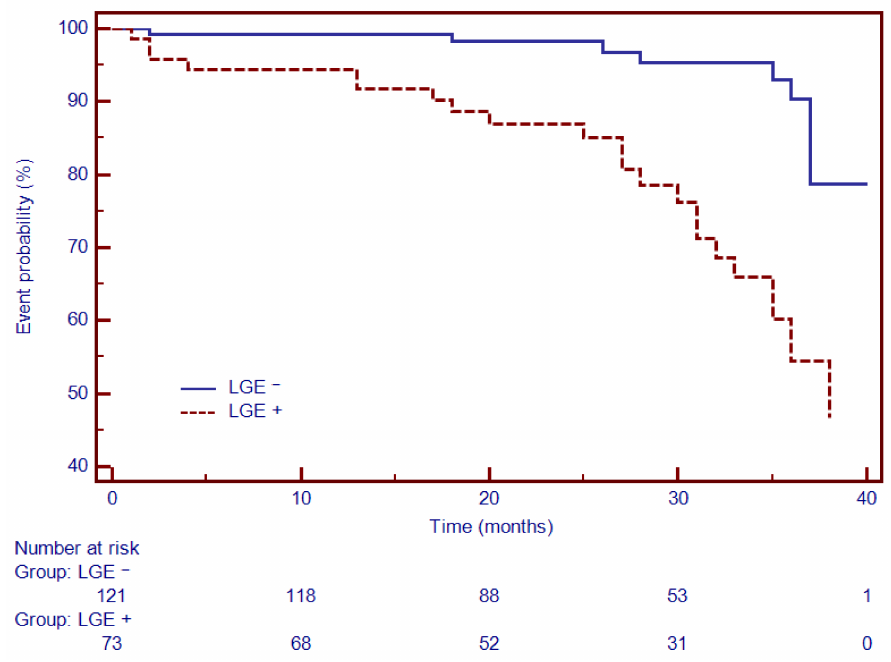
Figure 7. Kaplan–Meier analysis for the ability of LGE to predict cardiovascular outcome. Abbrevia- tions: LGE, late gadolinium Figure 7. Kaplan – Meier analysis for the ability of LGE to predict cardiovascular outcome. Abbre- viations: LGE, late gadolinium enhancement.